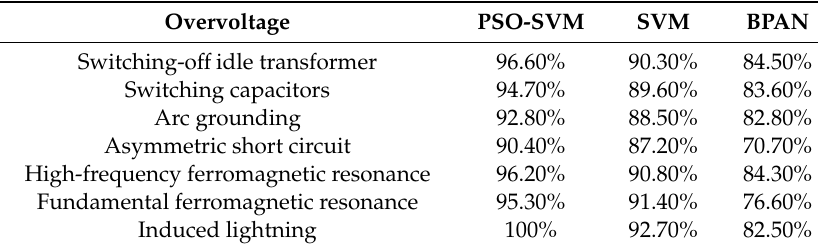
Table 4. Final classification rates of each kind of